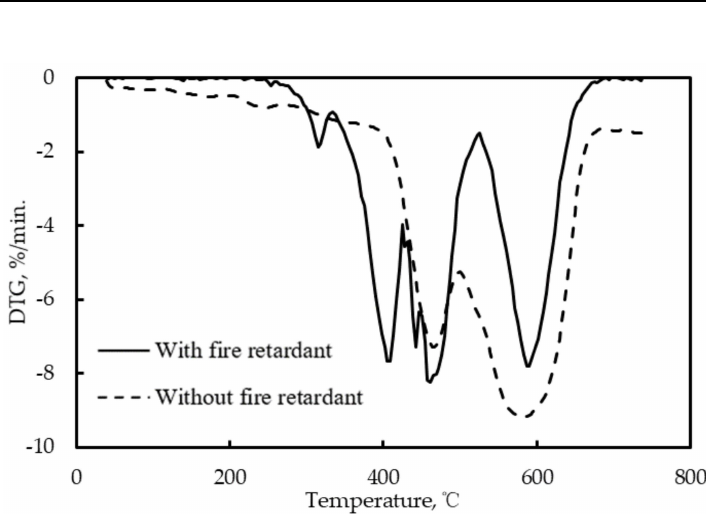
Figure 5. Typical DTG Curve of the Asphalt.